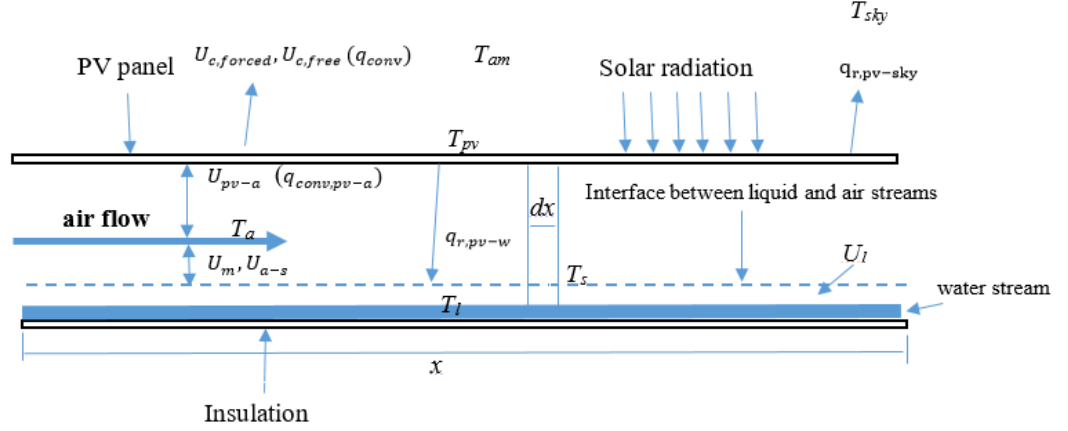
Figure 2. Side view of a heat and mass exchanger with direct contact between a binary gas mixture and a liquid .